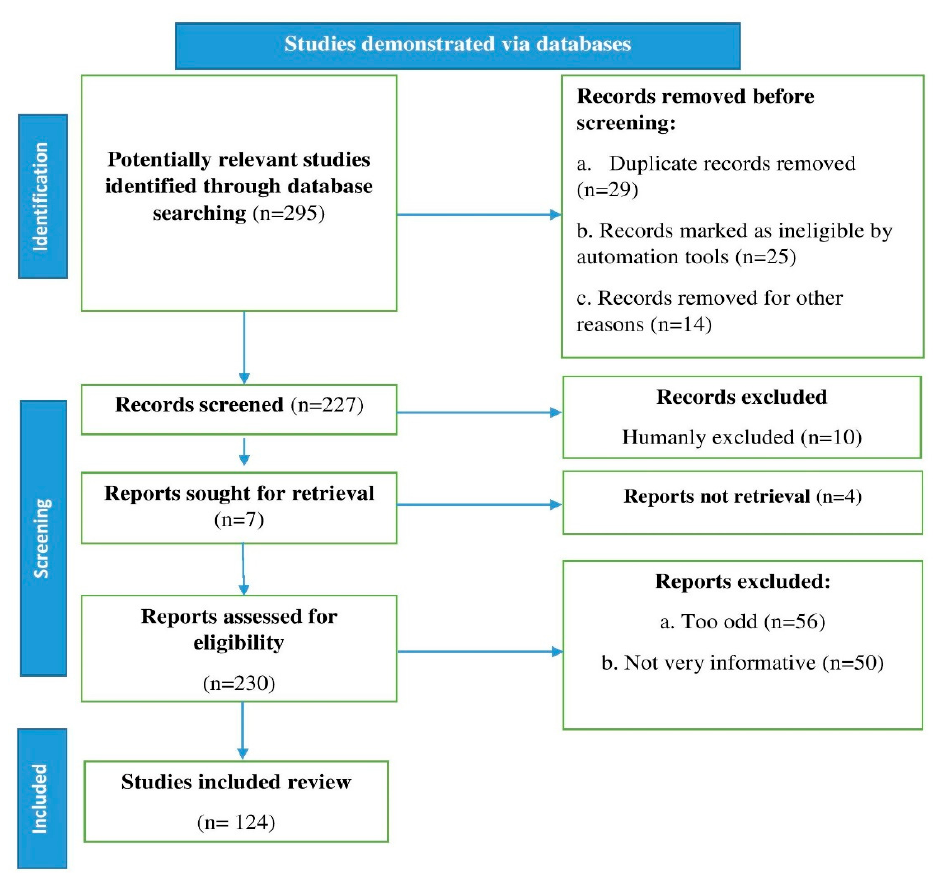
Figure 1. Stages involved in selecting published data for inclusions in the current study are depicted in a flow chart; n: number of literature reports.